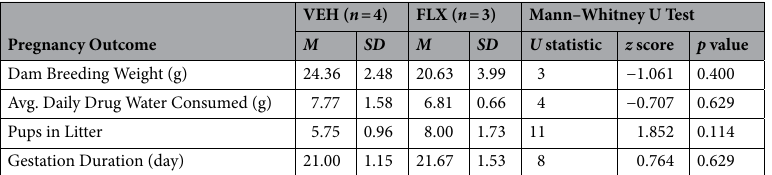
Table 1. Pregnancy outcomes between FLX- and VEH-exposed